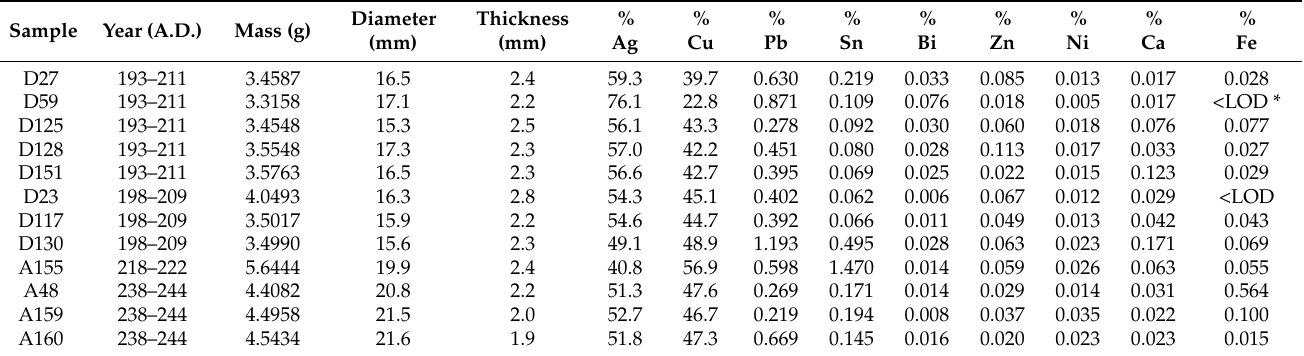
Table 3. Average concentrations in percentage (wt%) and mean physical data for the 12 coins subjected to micro-destructive